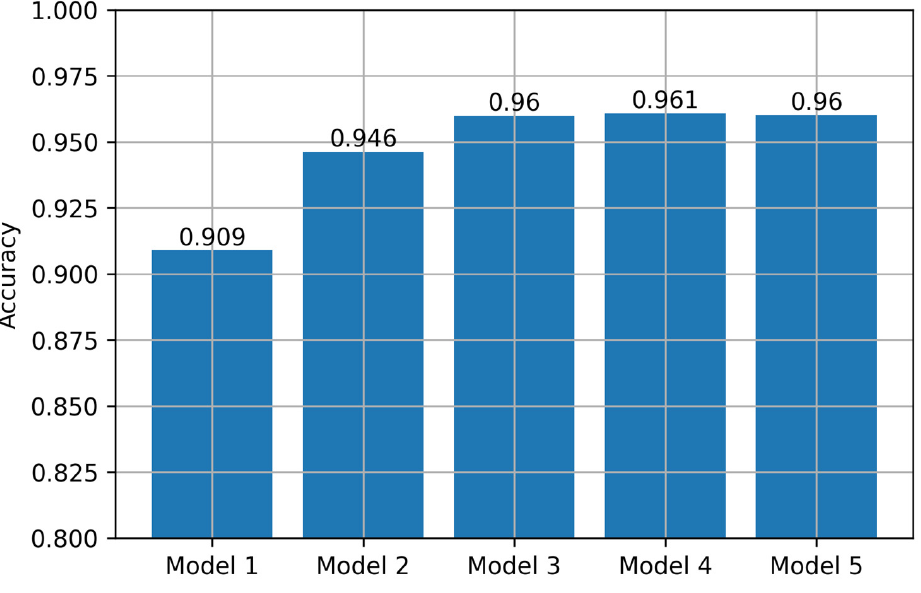
Figure 14. Accuracy of VGG19 models.